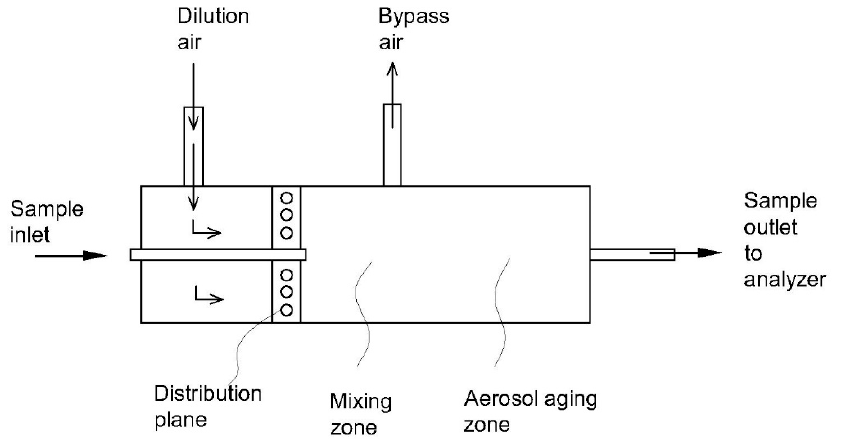
Figure 8. Schematic diagram of a dilution module [107].